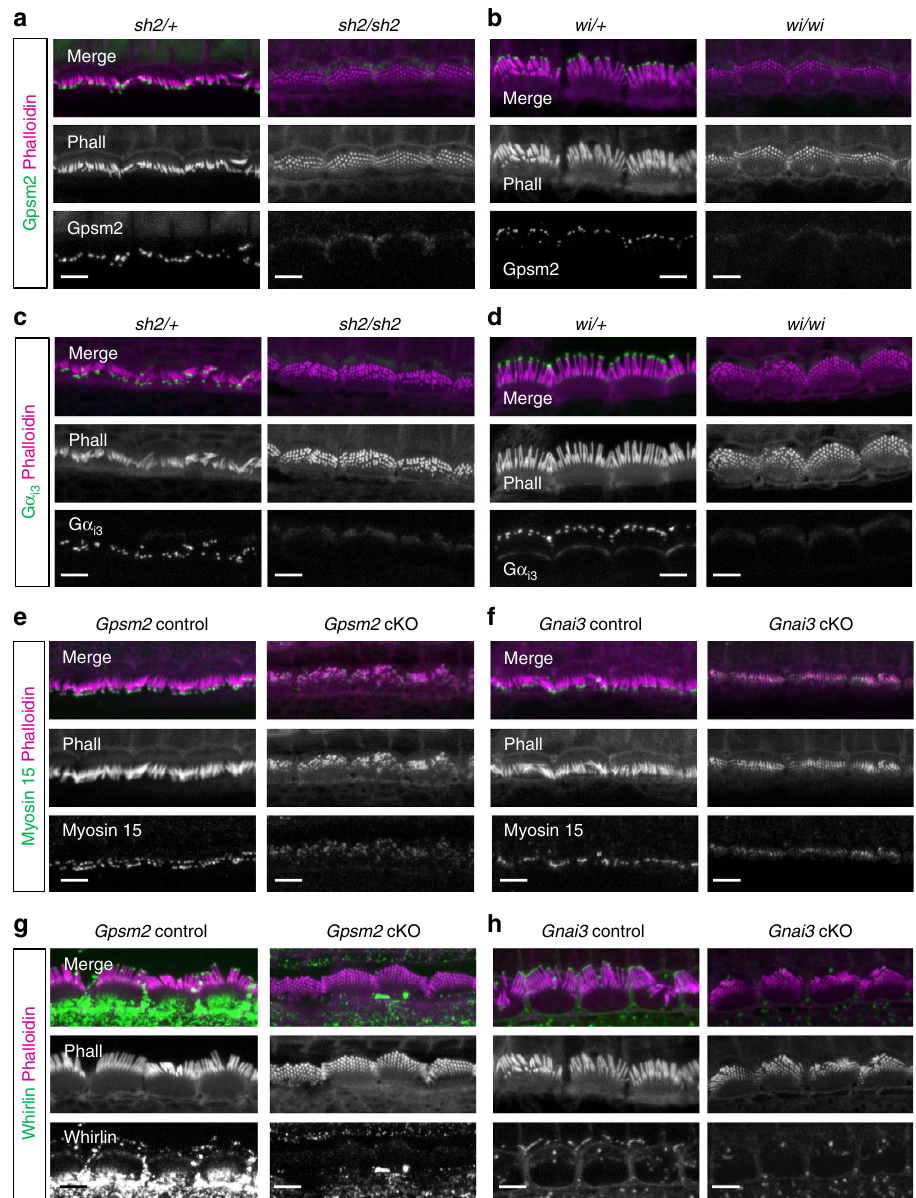
Figure 4 | Gpsm2 and G a i3 localization at stereocilia tips is dependent on myosin 15 and whirlin. ( a – d ) Immunocytochemistry for Gpsm2 ( a , b ) or G a i3 ( c , d ) and staining with phalloidin (Ph, magenta) shows protein localization at the tips of stereocilia in IHCs from shaker 2 ( sh2/ þ , a , c ) and whirler ( wi/ þ , b , d ) control mice at P8. Homozygous mutations ( sh2/sh2 and wi /wi ) lead to a loss of Gpsm2 and G a i3 stereocilia tip staining. The immunostainings were repeated four times. ( e , f ) Immunocytochemistry for myosin 15 (green) and staining with phalloidin (Ph, magenta) shows protein localization at tips of stereocilia in IHCs from controls of Gpsm2 ( e ) and Gnai3 ( f ) cKO P8 mice. Myosin 15 protein is still present at the tip of shortened stereocilia of both cKOs, though in reduced amounts. ( g , h ) Immunocytochemistry for whirlin (green) and staining with phalloidin (Ph, magenta) shows protein localization at tips of stereocilia in IHCs from controls of Gpsm2 ( g ) and Gnai3 ( h ) P8 mutant mice . Gpsm2 and Gnai3 mutation leads to a strong reduction of whirlin stereocilia staining. Scale bars, 4 m m. The immunostainings ( e – h ) were repeated six times and imaged